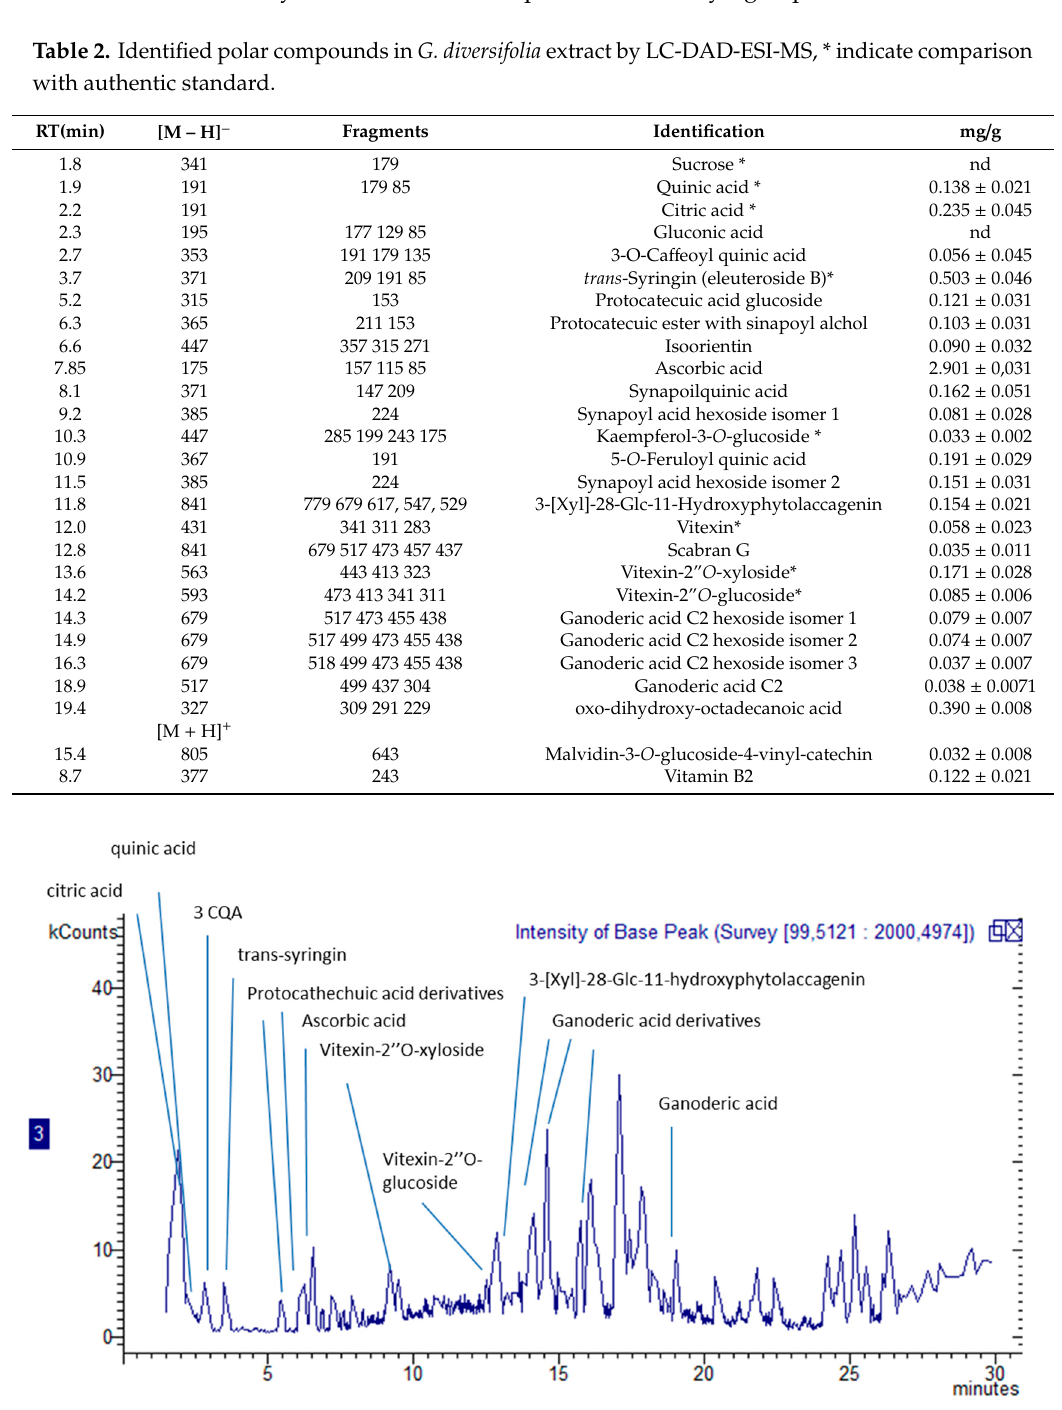
Figure 1. LC-MS chromatogram in negative ion mode; some of the identified peaks reported in Table 1 are highlighted. Table 1. Identified lipophilic compounds in G. diversifolia extract by LC-APCI-MS. Compounds were identified on the basis of literature data (CIT) and injection of authentic standards (*).